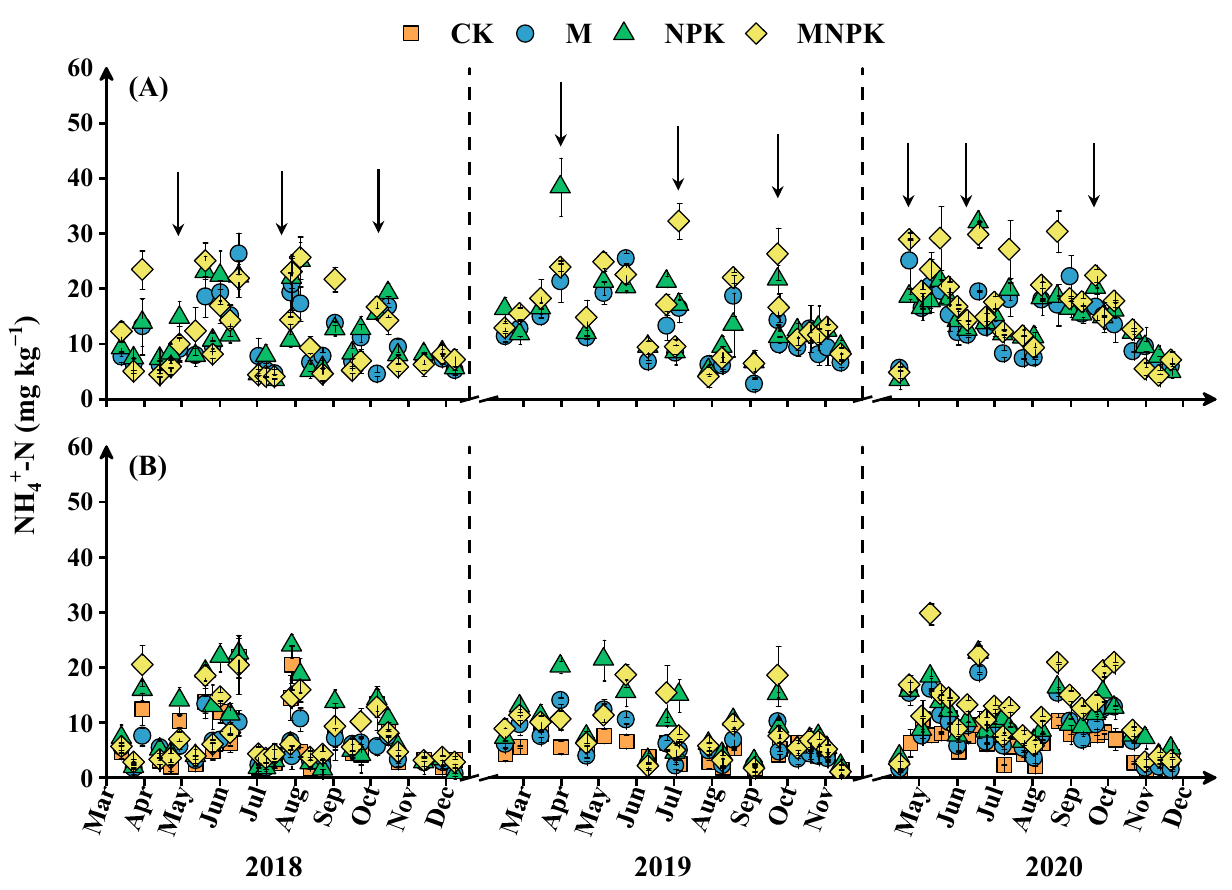
Figure 4. Seasonal dynamics of soil NH 4+ -N contents across all treatments from 2018 to 2020. ( A ) FD: fertilizer ditches, ( B ) BS: bare soil, CK: control, M: organic manure, NPK: chemical fertilizer, MNPK: chemical fertilizer combined with organic manure. The data points indicate the means of the four replicates, and the error bars indicate the standard error (±SE). The black arrows represent the date of fertilizer application.